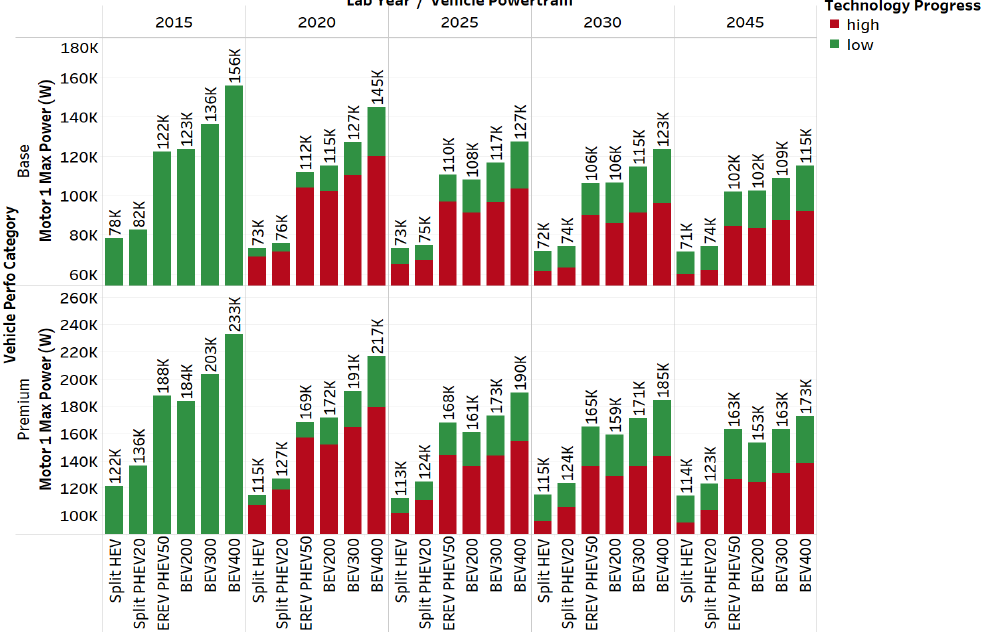
Figure 7. Motor peak power (W) for midsize